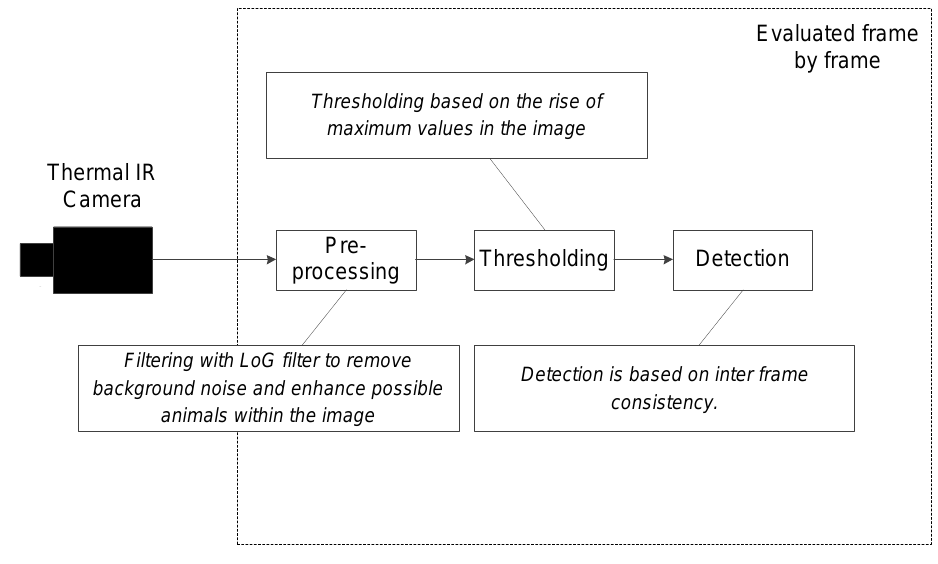
Figure 6. Flow of the image processing for the automatic detection of animals using thermal